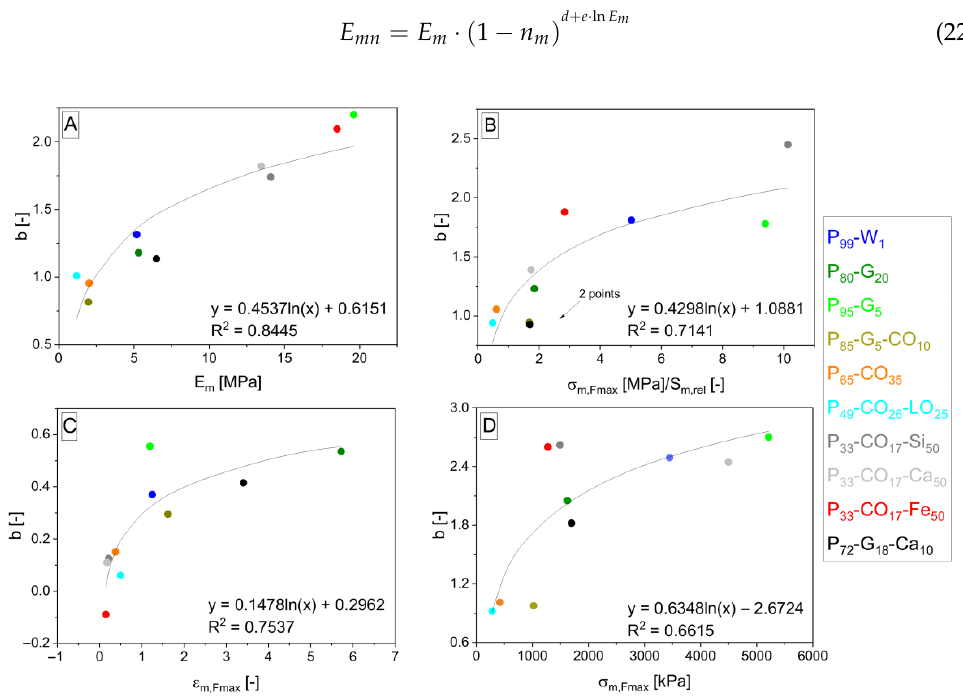
Figure 6. Logarithmic dependencies y = d + e · ln x of parameters b from general Equation (10) with different b values according to specification of property z into E ( A ), σ Fmax ( B ), ε Fmax ( C ) and A Fmax ( D ) interpolated by E m ( A ), σ m,Fmax /S m,rel ( B ), ε m,Fmax ( C ) and σ m,Fmax ( D ) values from Table 4 except S m,rel from Equation (20). The resulting dependencies correspond to exponent d + e · ln x in Equations (12) – (15) arising from Equation (10) in the order from ( A ) to ( D ).